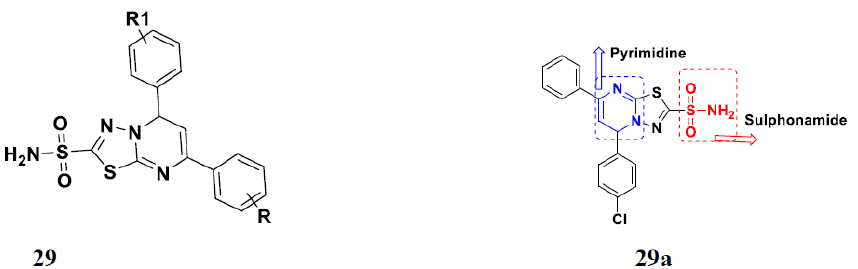
Figure 32. Structure of sulfonamide-thiazole fused pyrimidine hybrids and the most promising compound 29a. Table 22. In vitro cytotoxic activities of sulfonamide ‐ thiazole fused pyrimidine hybrid compounds 29 ( b – e ).